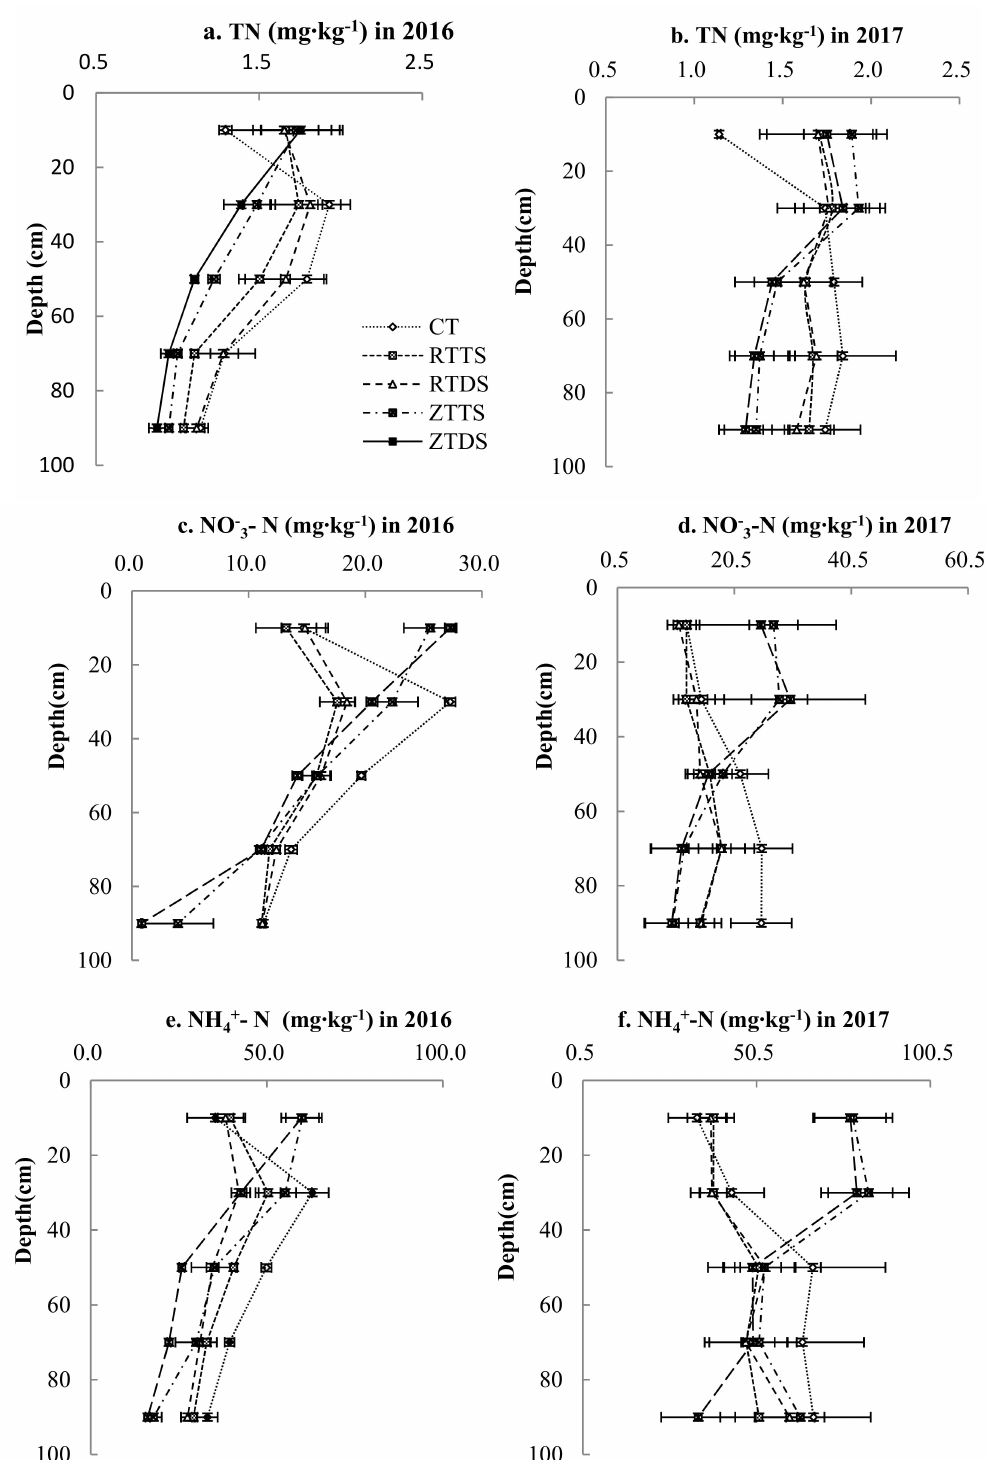
Figure 5. E ff ects of tillage on soil TN, NO 3 − -N, NH 4 + -N distribution along the soil profile. Note: ( a ) TN in 2016; ( b ) TN in 2017; ( c ) NO 3 − -N in 2016; ( d ) NO 3 − -N in 2017; ( e ) NH 4 + -N in 2016 and; ( f ) NH 4 + -N in